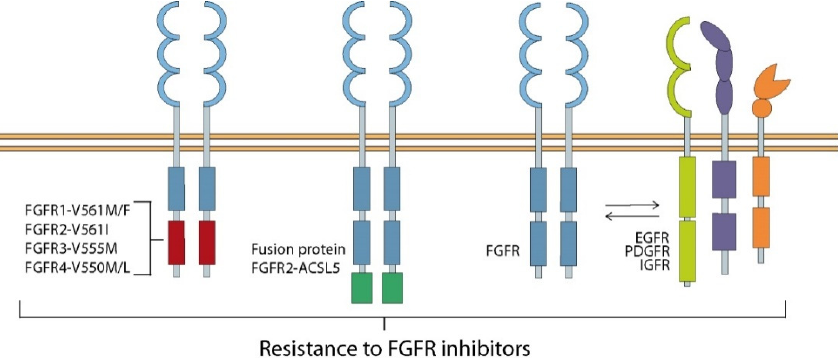
Figure 5. Mutations and molecular cross-talks in the acquisition of resistance to FGFR inhibitors. The use of TKIs in cancer cells expressing FGFRs leads to the acquisition of gatekeeper mutations in the FGFR kinase domain (FGFR1-V561M/F, FGFR2-V561I, FGFR3-V555M, and FGFR4-V550M/L), which in turn desensitize cells to the inhibitor used and may also induce cross-resistance to other inhibitors. FGFR2-ASCL5 fusion leads to the development of resistance to LY2874455, an FGFR inhibitor that overcomes resistance caused by gatekeeper mutations. FGFR inhibition can also lead to the activation of other RTKs, including EGFR, PDGFR, and IGFR, which alternatively trigger downstream cell signaling and render cells insensitive to